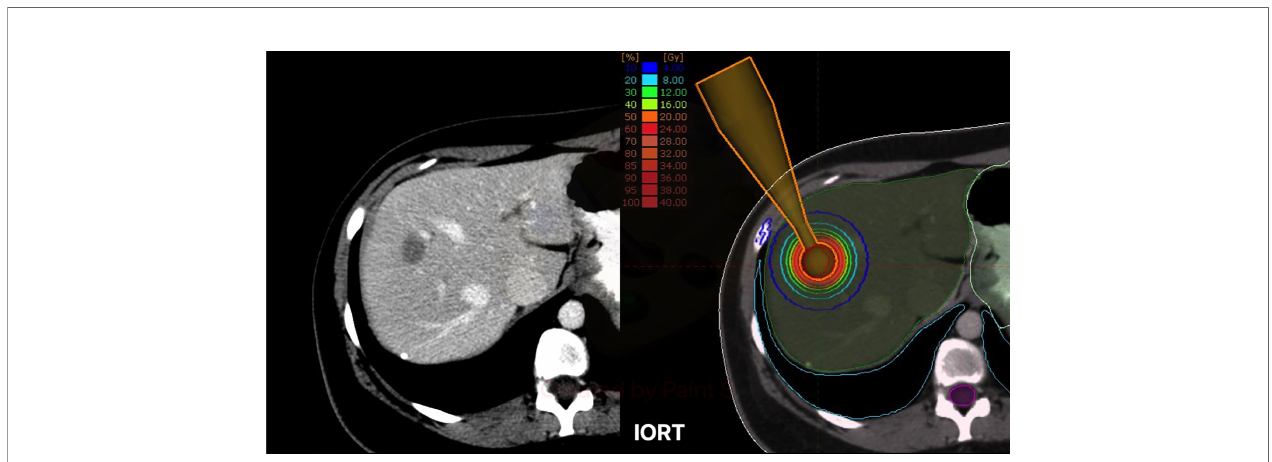
FIGURE 1 | Left: Exemplary case with a single liver metastasis in segments VII-VIII. Right: Exemplary dose distribution pro fi le with isodose lines for a simulated resection cavity. IORT,